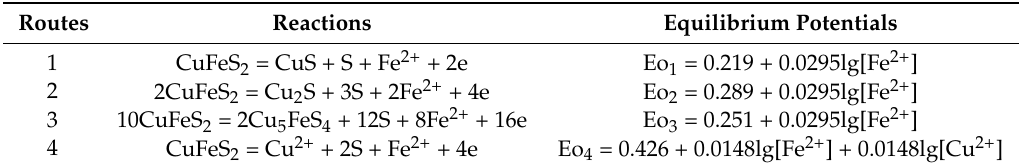
Table 1. The equilibrium potentials of selected possible oxidative dissolution reaction routes of CuFeS 2 in sulfuric acid